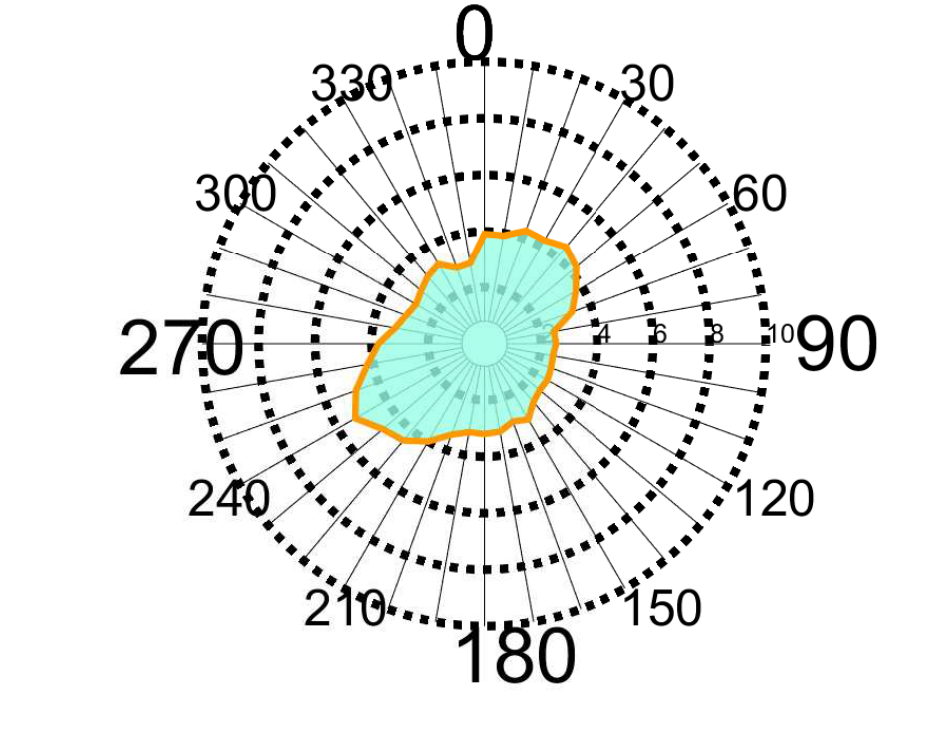
Figure 13. Rose portrait of Wind Mean Speed (m/s) in OSWFs of Yangshan port, Shanghai from 22 August 2017 to 22 August